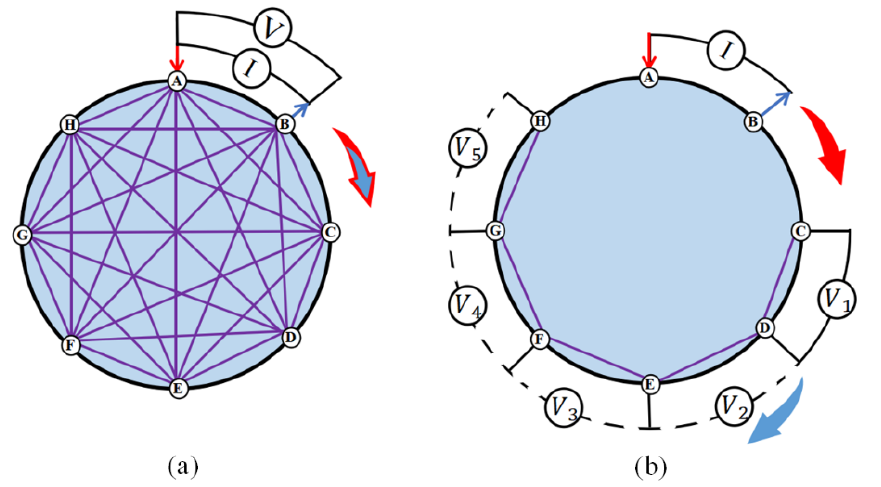
Figure 2. Two drive patterns. ( a ) Two-terminal scheme with eight electrodes. ( b ) Four-terminal scheme with eight electrodes. In the figure, the I represents the location of the injected excitation, and V represents the location of the voltage measurement. The red and blue arrows represent the direction of movement of the excitation and measurement electrodes, respectively.